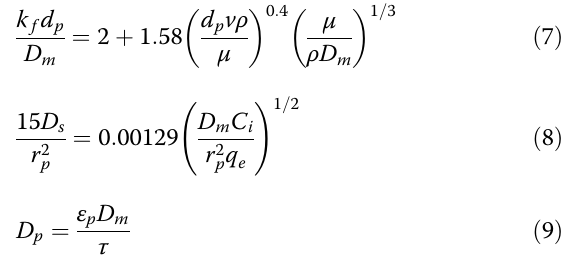
where D m is the molecular diffusivity of SMX (m 2 s − 1 ), d p is the particle diameter of the adsorbent (m), v is the superficial velocity of the SMX solution (m s − 1 ), ρ (kg m − 3 ) and μ (kg m − 1 s − 1 ) are the density and the dy- namic viscosity of the SMX solution, r p (m) and ɛ p are the radius and porosity of the adsorbent particle (Table 3), and τ is the tortuosity factor of the adsorbent. D τ were estimated using Eqs. (10) and (11) [24]. m and